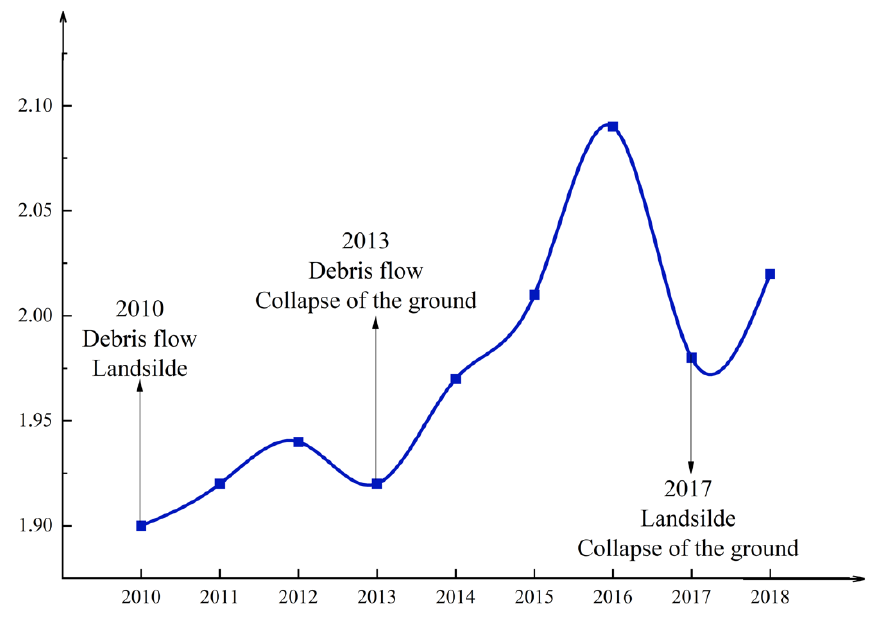
Figure 2. Changes in disaster resilience in Aba from 2010 to 2018.